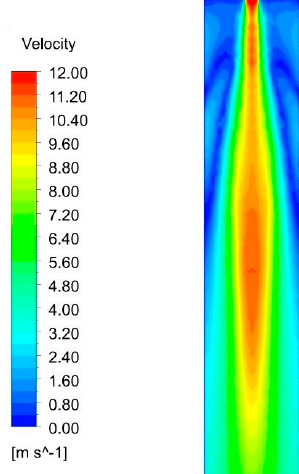
Figure 3. Velocity contour on the symmetry plane.